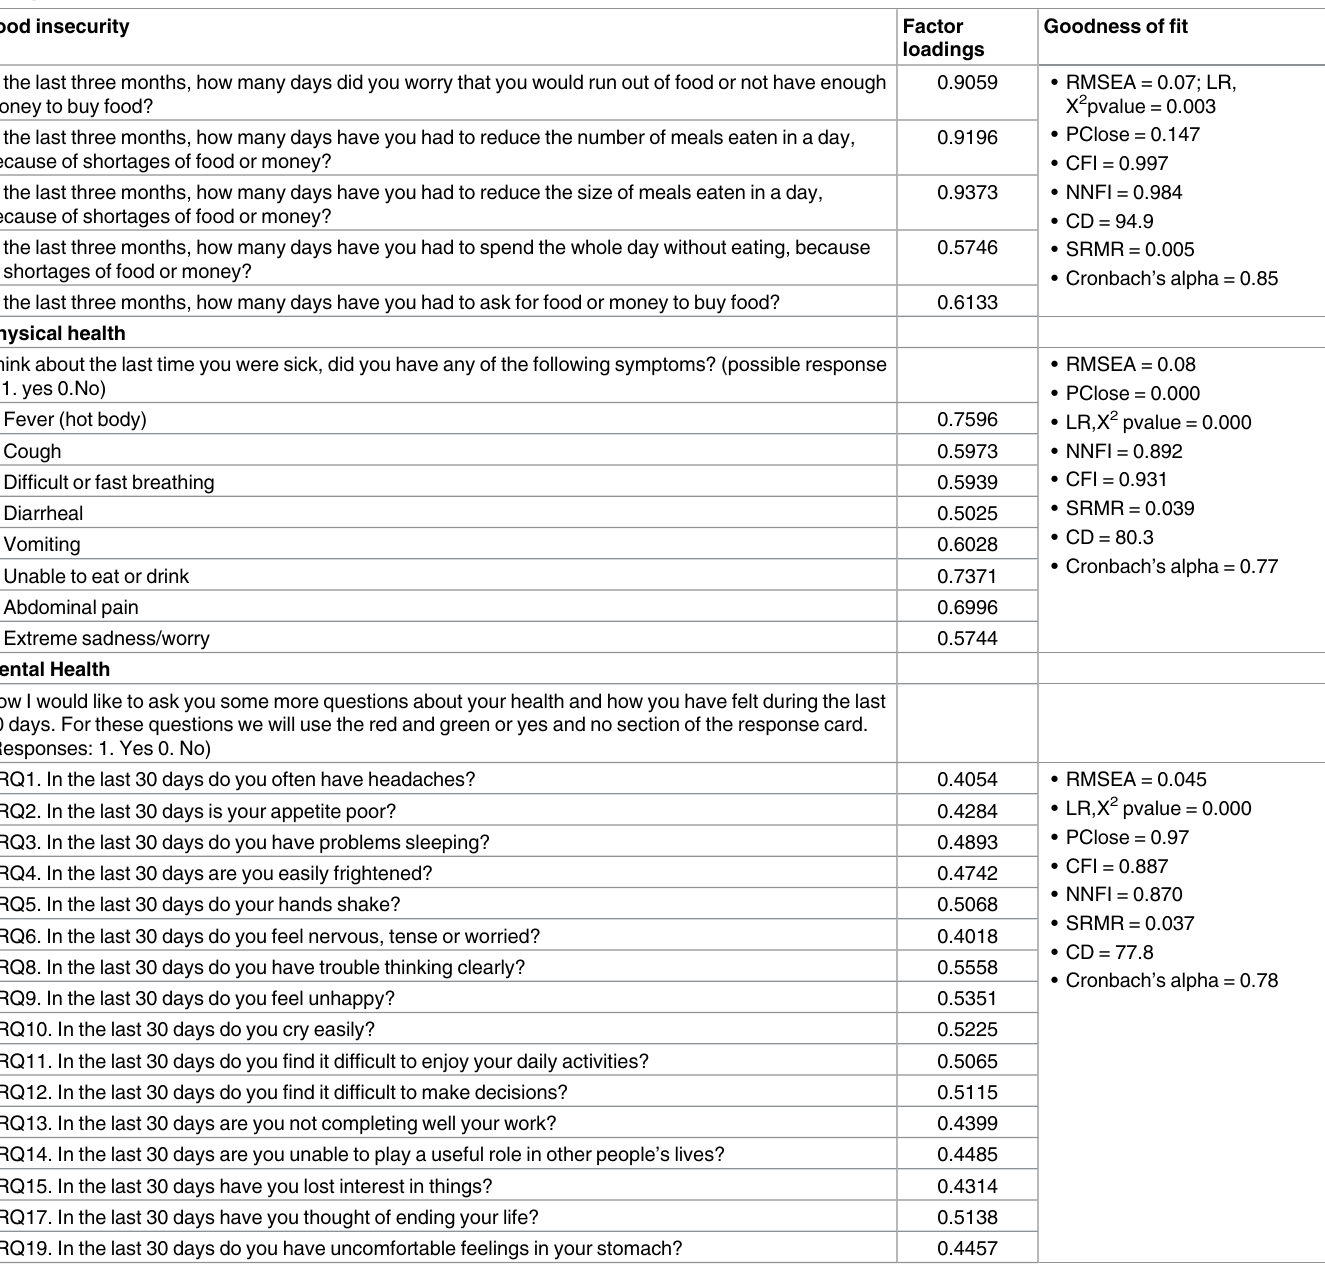
Table 2. Internal consistencies, model fitness and factor loadings of food insecurity, physical health and mental health items, JLFSY, Southwest Ethiopia, 2015. Food